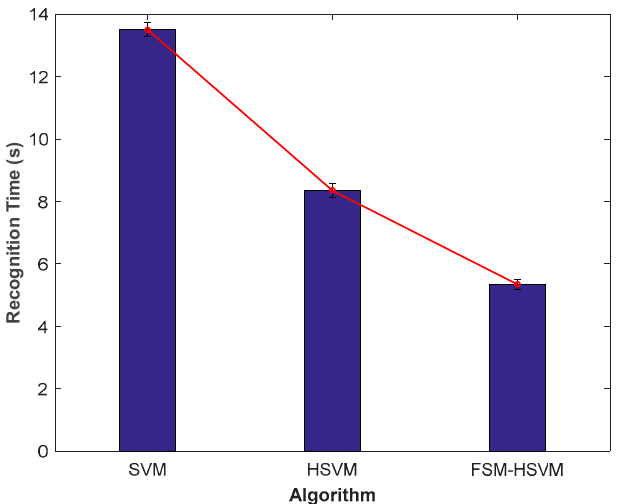
Figure 7. Comparison of recognition time of three algorithms.